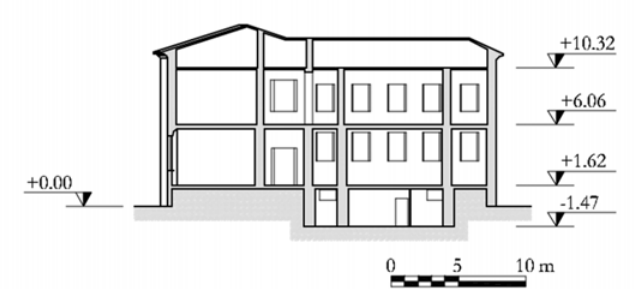
Figure 3: Survey of “Pietro Capuzi” school: section AA (indicated in plan in Figure